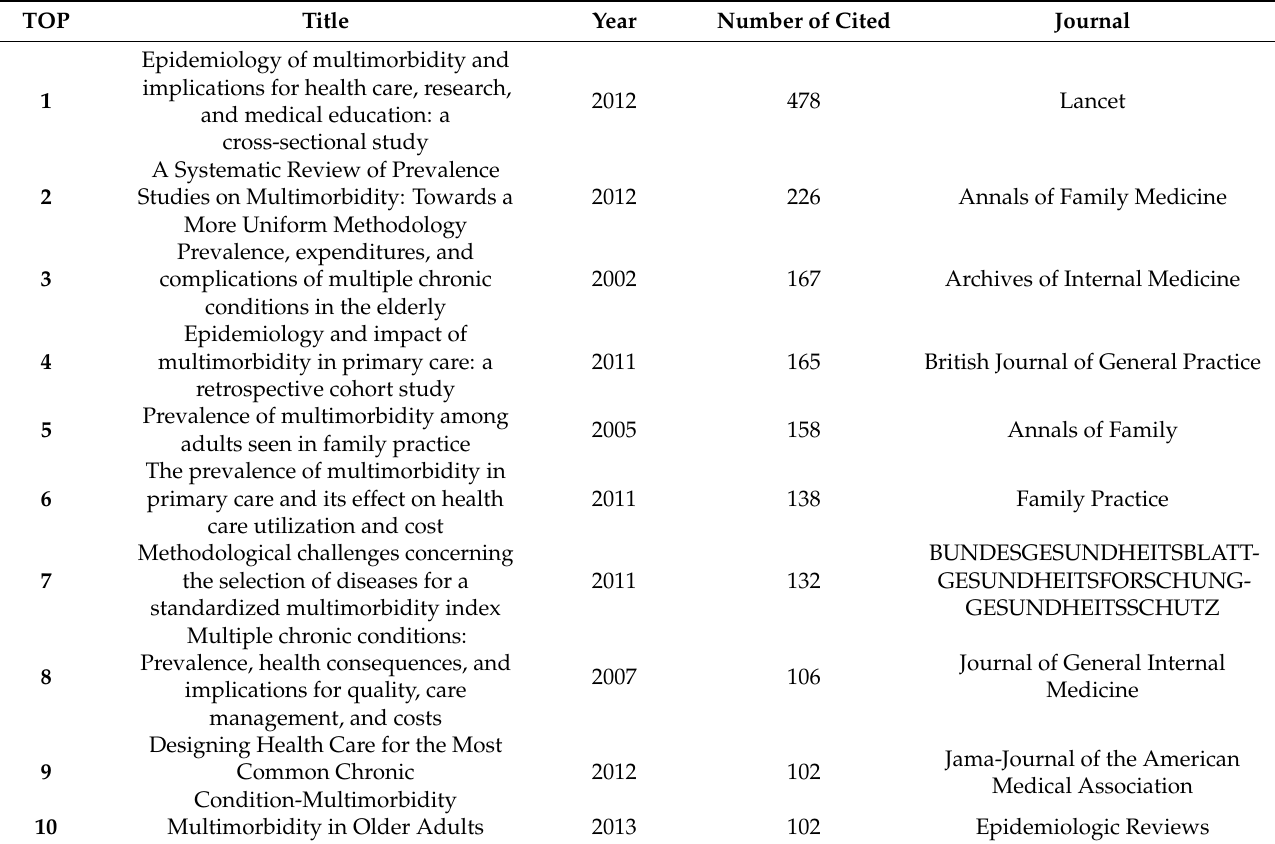
Table 7. TOP 10 highly cited papers in